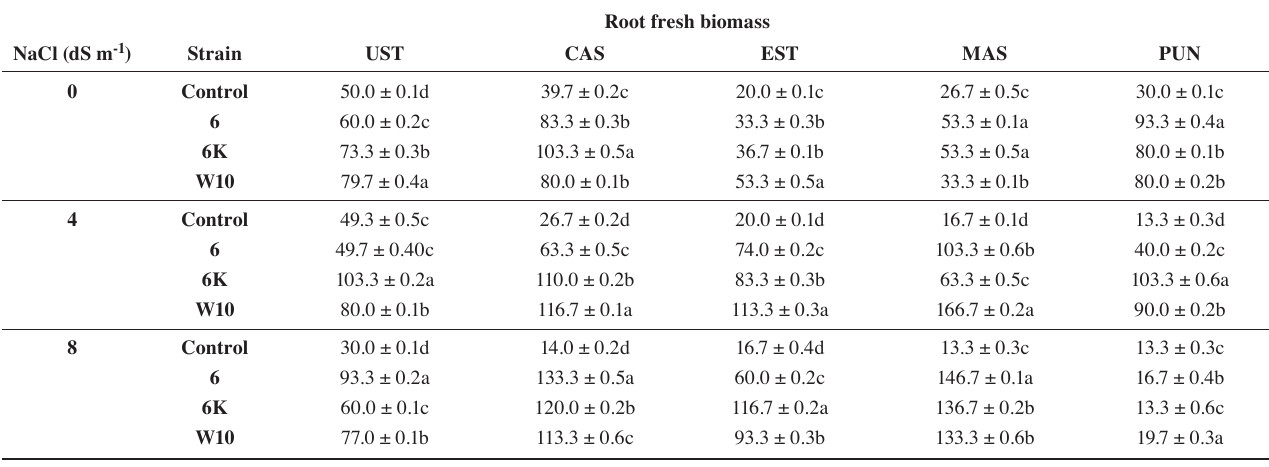
Tab. 2: Root fresh biomass (mg plant -1 ) (n = 3) in inoculated lentils Ustica (UST), Castelluccio (CAS), Eston (EST) Masoor 85 (MAS) and Punjab Masoor 2009 (PUN) with the different strains (6, 6K, W10) in respect to the un-inoculated one (control), in absence (0 dS m -1 ) and in presence of NaCl salinity (4 and 8 dS m -1